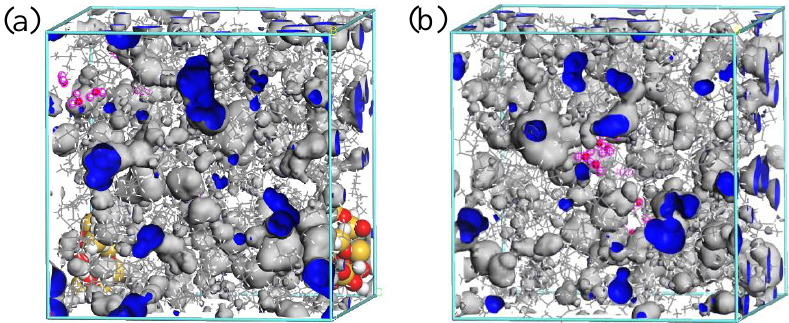
Figure 5. Free volume diagrams of the statistical Connolly surfaces for models ( a ) with and ( b ) without nano-SiO 2 , the blue area is the free volume and the gray area is the occupied